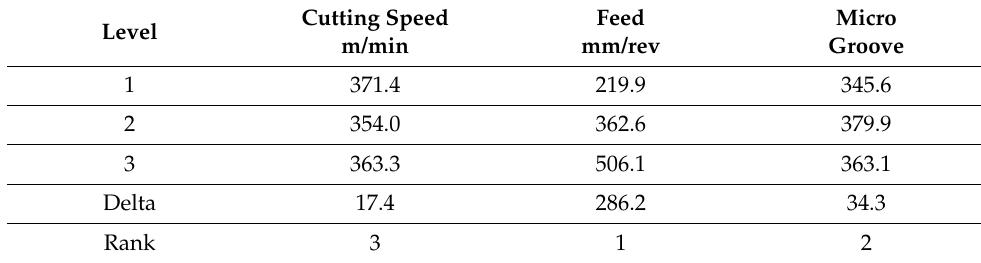
Table 9. Total cutting power: Mean